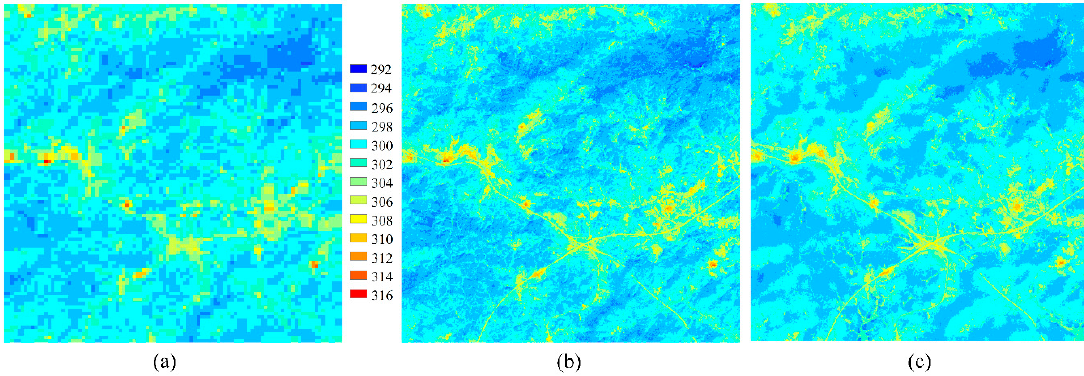
Figure 9. Spatial distribution of LSTs in region B. ( a ) 90 m ASTER LST; ( b ) 10 m RFATPK LST; and ( c ) 10 m TsHARP LST.